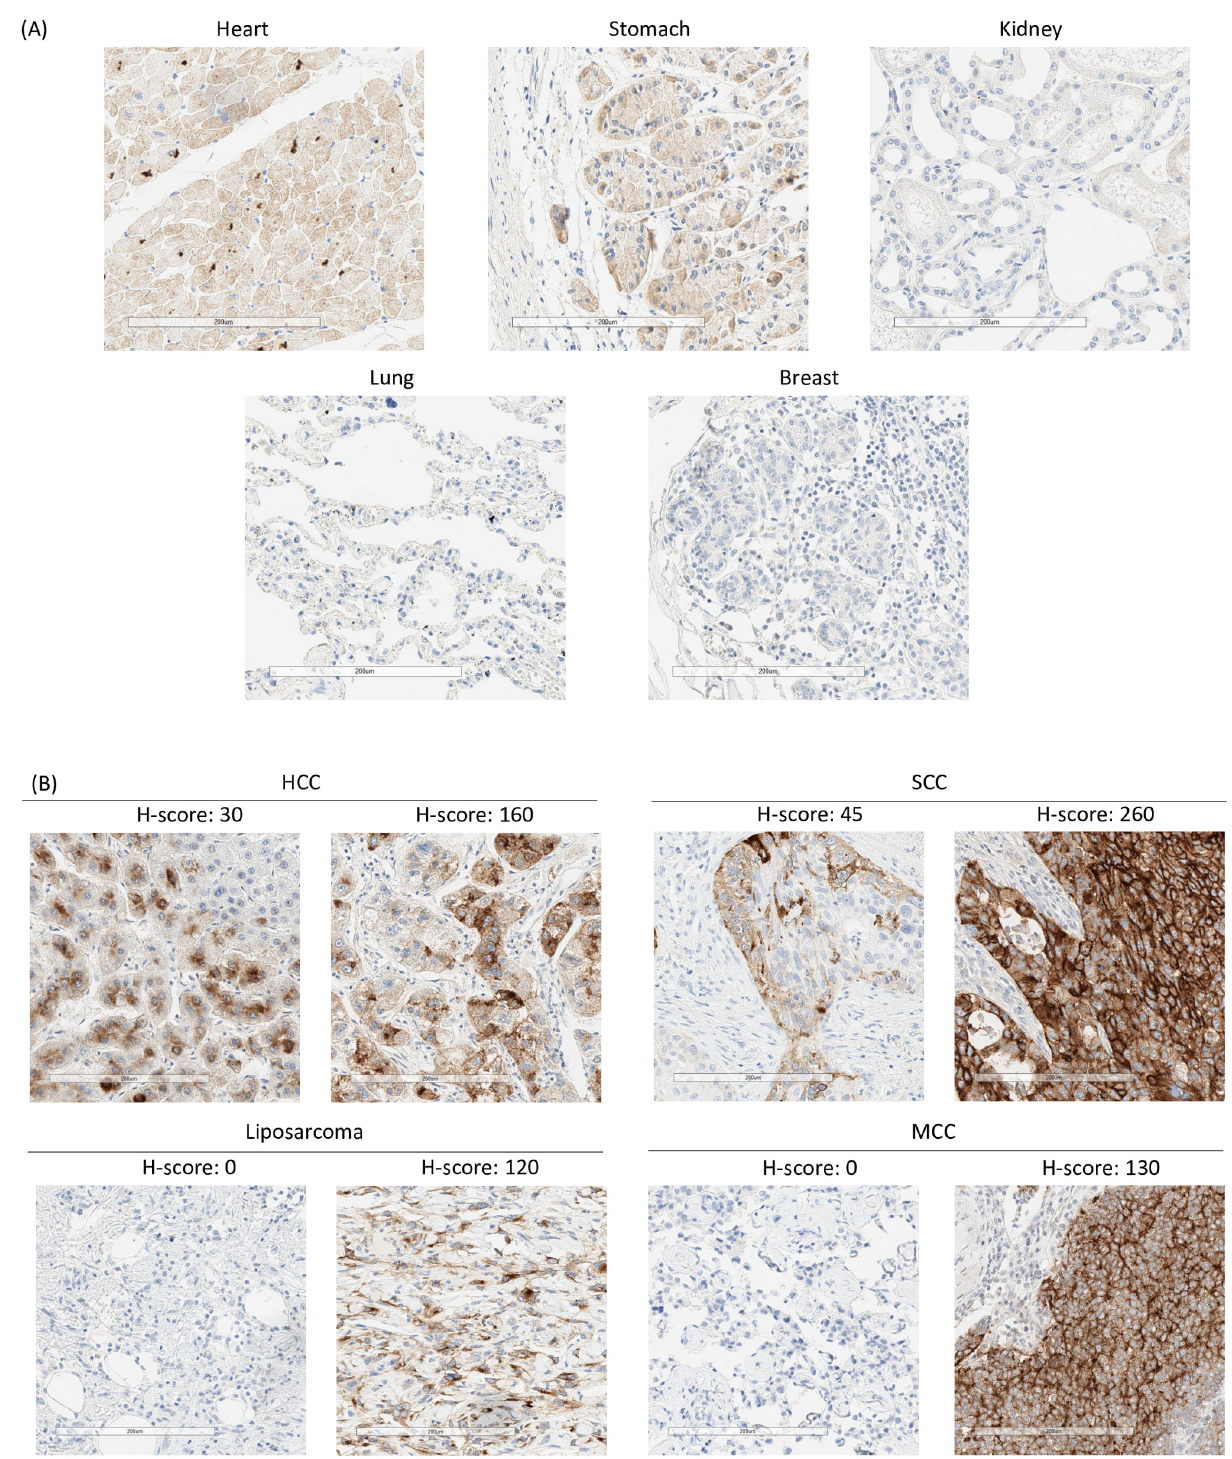
Fig 1. GPC3 target expression in human normal and tumor tissues by IHC. (A) Immunohistochemical staining of normal healthy TMA for GPC3 expression. Representative images (20x magnification) of different organs with different levels of GPC3 are shown (B) IHC staining of tissues from hepatocellular carcinoma (HCC), squamous cell lung cancer (SCC), Merkel cell carcinoma (MCC) and liposarcoma patients for GPC3 expression. Representative images (20x magnification) show samples with different levels of GPC3 (and H-scores).